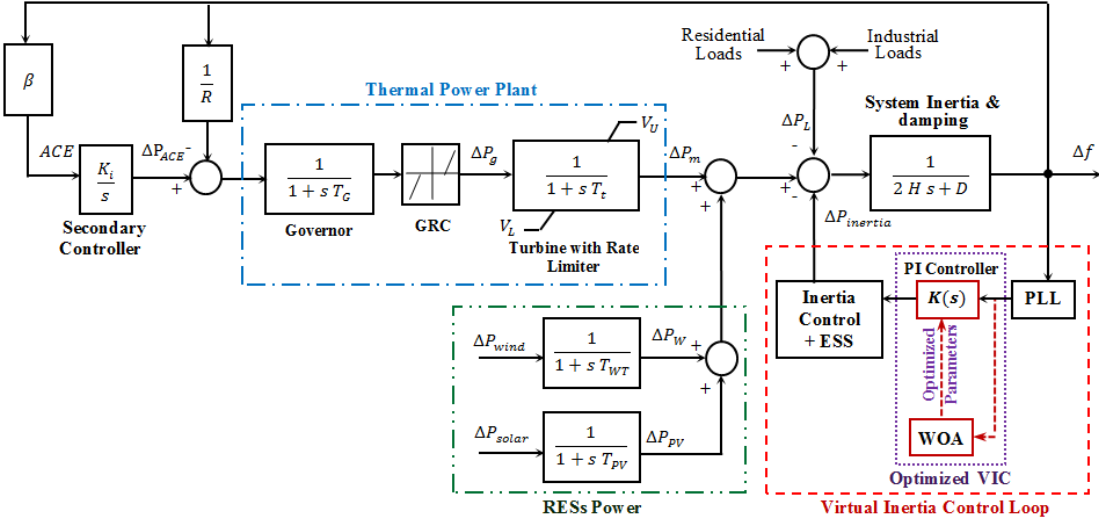
Figure 2. Dynamic structure of the microgrid.